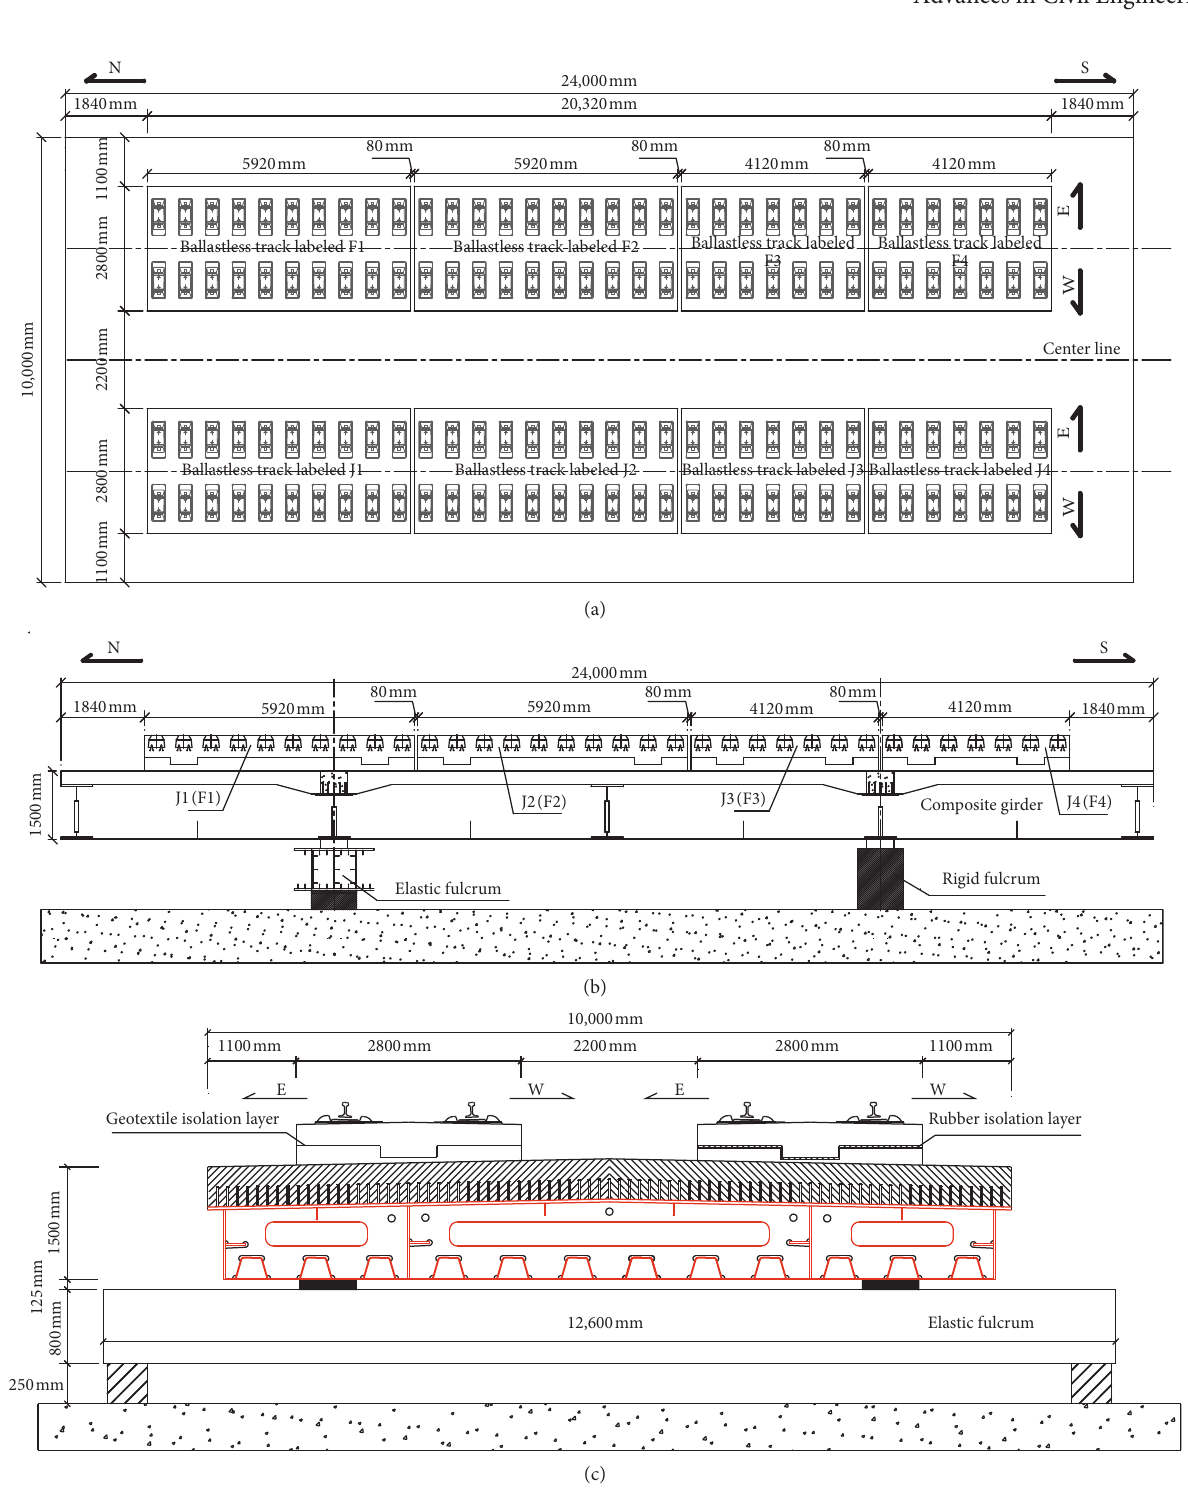
Figure 3: Structures of the segment model and unballasted tracks. (a) Top view of the segment model and unballasted tracks. (b) Side view of the segment model and unballasted tracks. (c) Front view of the segment model and unballasted